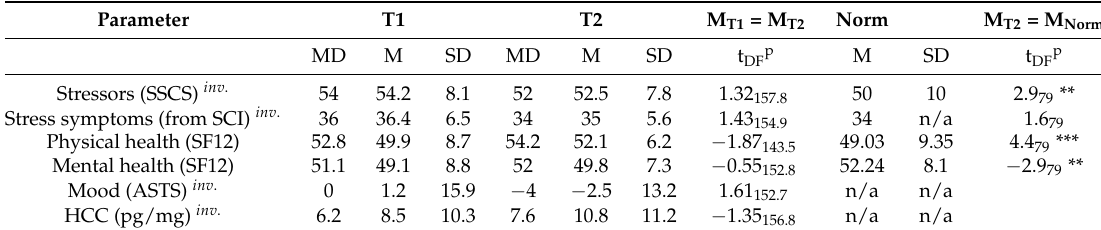
Table 1. Descriptive statistics for the scales used in the questionnaires and the cortisol measurements. Parameter T1 T2 M T1 = M T2 M T2 = M Norm Stressors (SSCS) inv